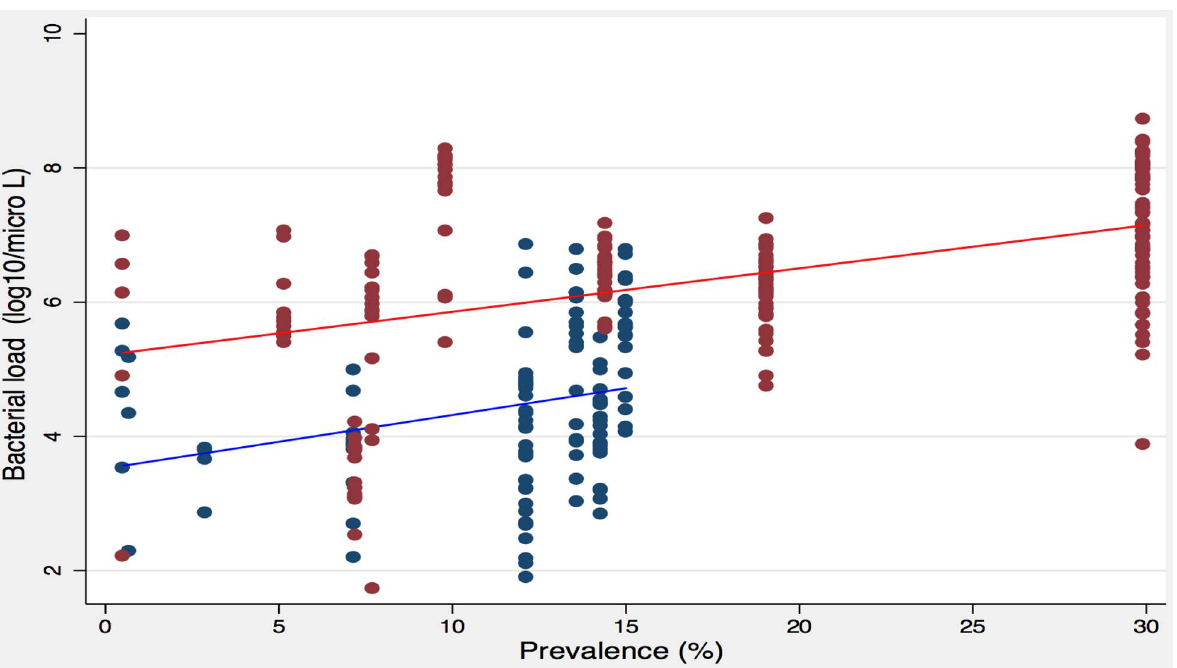
Figure 4. Relationship between bacterial load of specific serotypes/serogroups and their prevalence. Bacterial load of each of specific serotypes/serogroups was plotted against its prevalence. Both in ARI cases (red) and in healthy children (blue), a positive correlation was found. Each dot represents an ARI case or a healthy child in the plot, and the red and blue lines are the fitted values for ARI cases and healthy children respectively. Spearman’s rho was 0.44 (n=186; P , 0.0001) and 0.41 (n=115; P , 0.0001) for ARI cases and healthy children respectively.